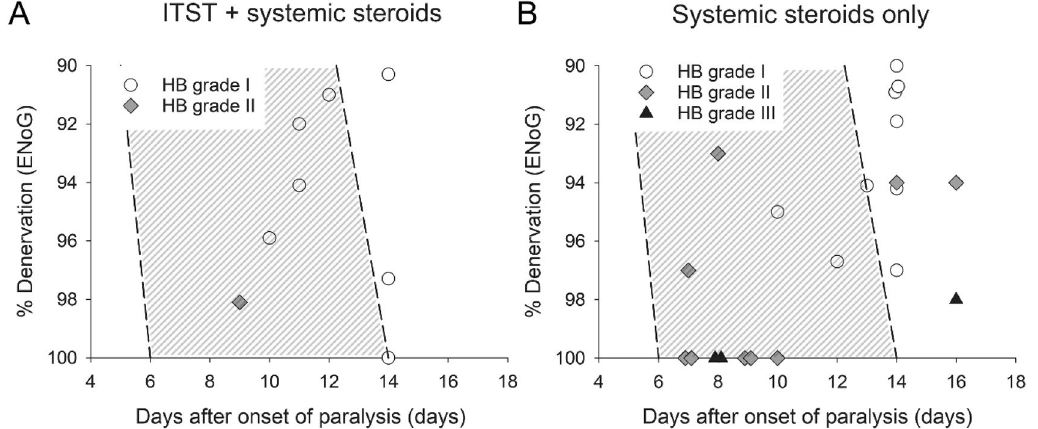
Figure 3. Correlation between the degree of facial nerve degeneration and days after facial palsy onset. Each symbol represents one patient’s facial outcome 12 months after facial palsy onset. The x-axis represents days after onset of facial palsy and the y-axis represents the degree of facial nerve degeneration as observed via ENoG. The shaded regions in each figure indicate the values that Fisch suggested would indicate complete degeneration of the facial nerve in Bell’s palsy 8 . Note that 6 of 8 patients in the concurrent ITST group and 11 of 21 patients in the control group had complete facial nerve degeneration according to these criteria. ENoG , electroneurography; HB , House-Brackmann; ITST , intratympanic steroid